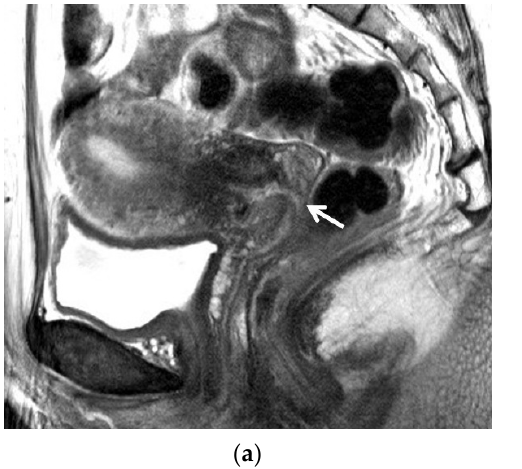
Table 1. Samsung Medical Center parameters for 3T MRI of cervical cancer.